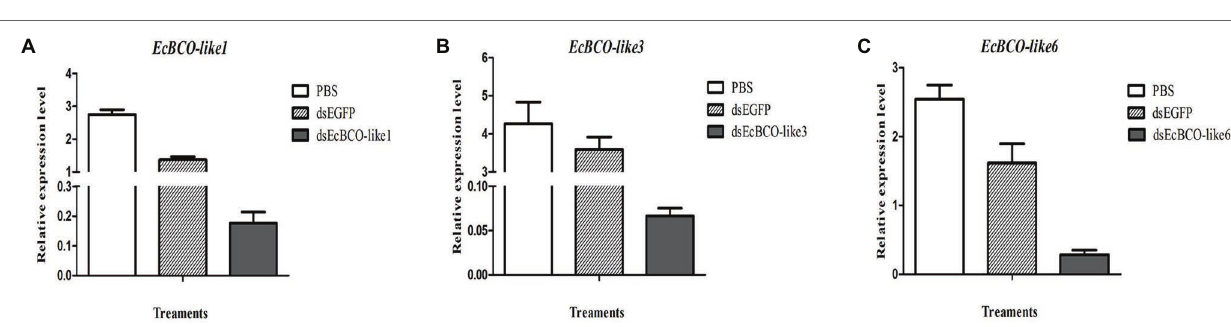
FIGURE 4 | The mRNA expression of EcBCO-like genes after injection of dsRNA. (A) mRNA expression of EcBCO-like1 . (B) mRNA expression of EcBCO-like3 . (C) mRNA expression of EcBCO-like6 . Two microgram double-stranded RNA (dsRNA) of EcBCO-like1 , four microgram dsRNA of EcBCO-like3 and EcBCO-like6 was injected into one individual, respectively. Significant differences of the expression levels between treatment group ( EcBCO-like dsRNA injection group) and control group ( EGFP dsRNA and PBS injection group) were identified. The other EcBCO-like genes were also different from the BCO1 and BCO2 genes in vertebrates. These data raised our attention to investigating the function of BCO-like genes in E. carinicauda .